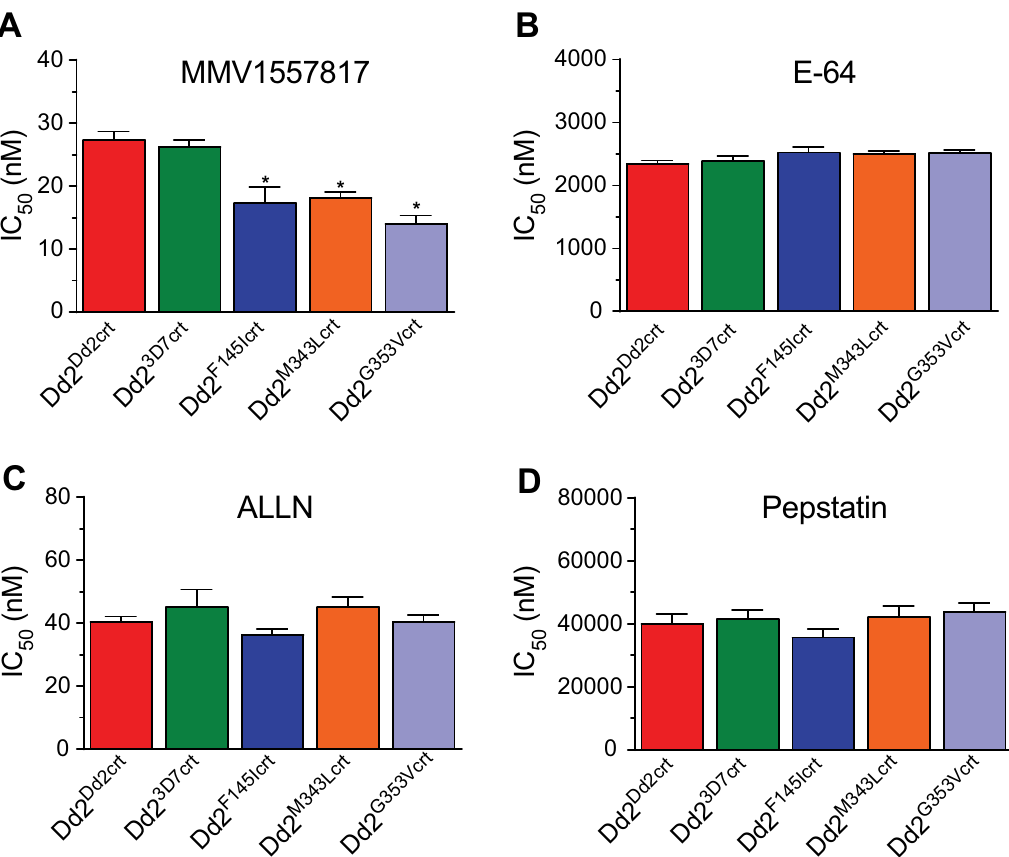
Fig 6. PfCRT-mutant PPQ parasites show increased susceptibility to aminopeptidase M17 inhibition. Dose–response plots illustrate susceptibility of PfCRT mutants to aminopeptidase inhibition. Half maximal inhibitory concentrations (IC 50 and IC 90 ) are presented as the mean ± SEM (N, n = 4, 2) for (A) MMV1557817; (B) E-64; (C) ALLN; and (D) pepstatin, as determined from conventional 72 hr dose–response assays performed with asynchronous parasite cultures. Mean ± SEM IC 50 and IC 90 values are shown in S6 Table . Statistical significance was determined using Mann–Whitney U tests comparing the PfCRT mutant lines with their isogenic Dd2 Dd2crt parent. � p < 0.05; ns, not significant.